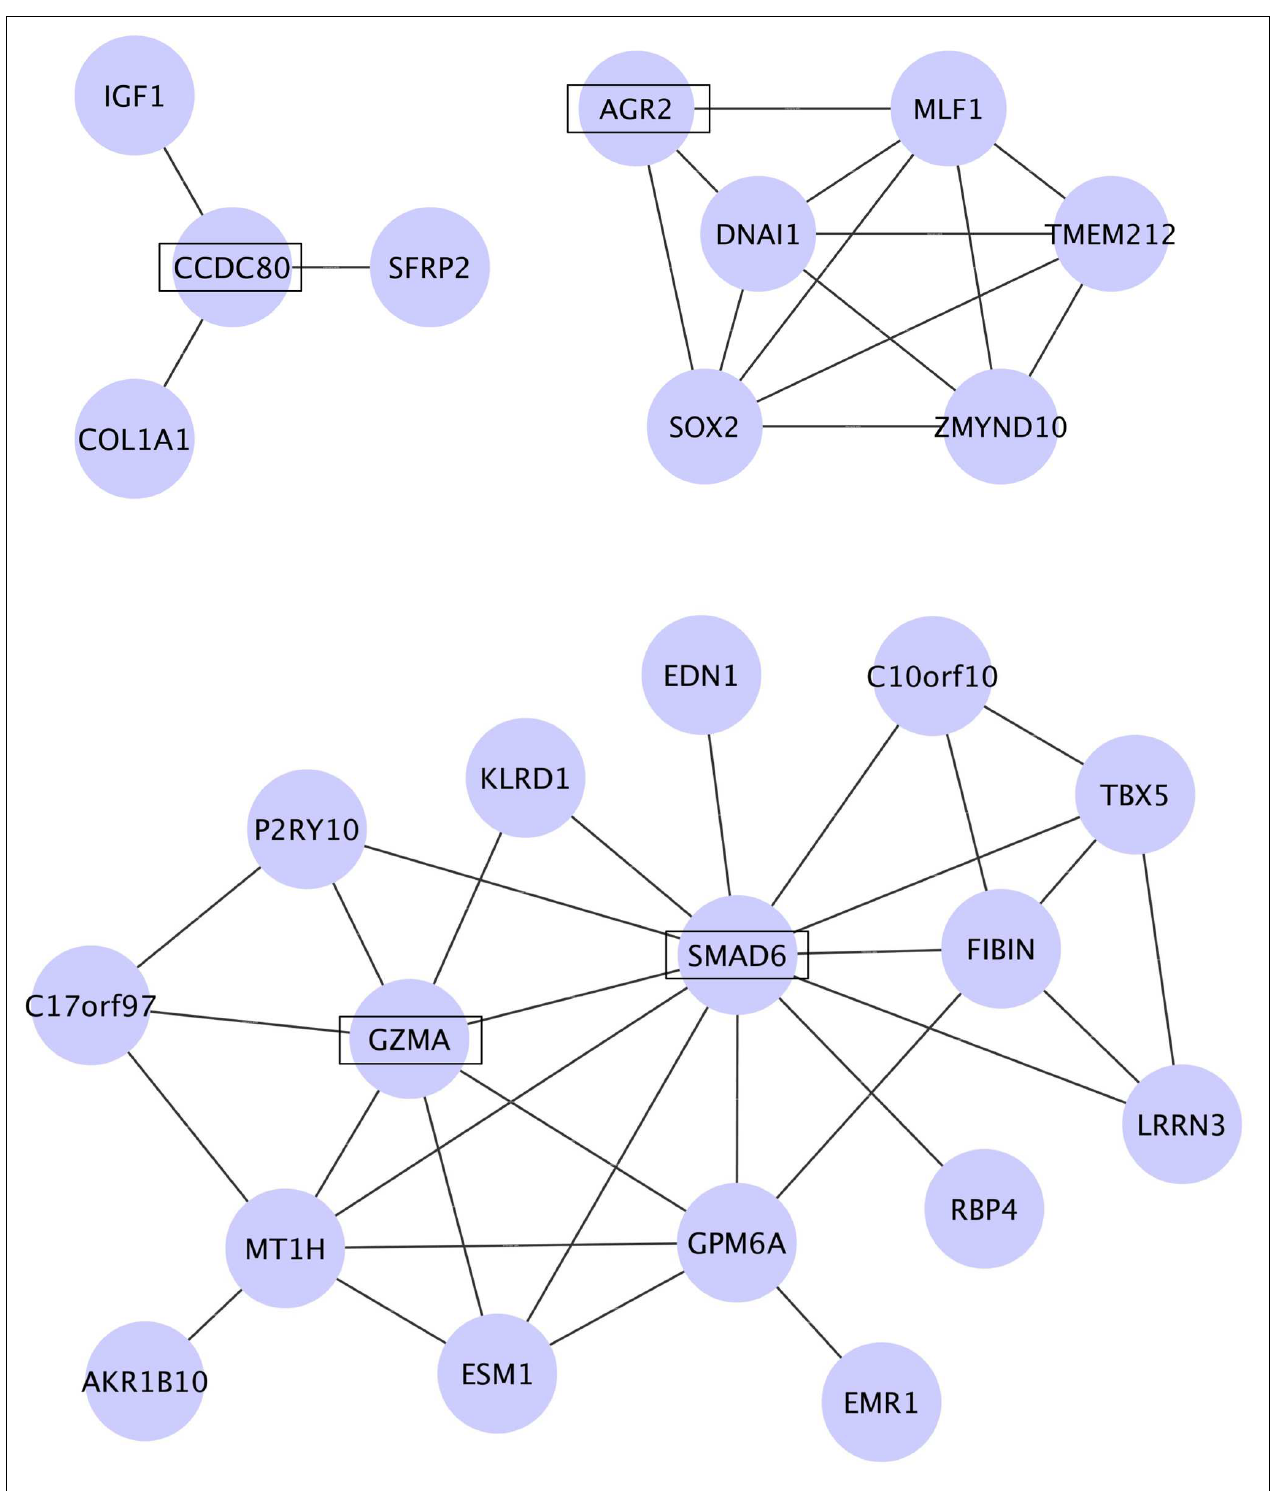
FIGURE 2 | Networks among the genes dysregulated in PAH identified by WGCNA. The coefficient of variation (CV) of the normalized probe intensity for each gene in each transcriptome dataset was calculated, and the genes were sorted in descending order by CV. Of the top 3000 genes in each dataset, 40 genes were common to all five datasets and were subjected to WGCNA. The genes were clustered into three modules and the networks identified in these modules are shown. CCDC80 , AGR2 , SMAD6, and GZMA , which were significantly dysregulated in all five PAH transcriptome datasets, are shown in boxes.